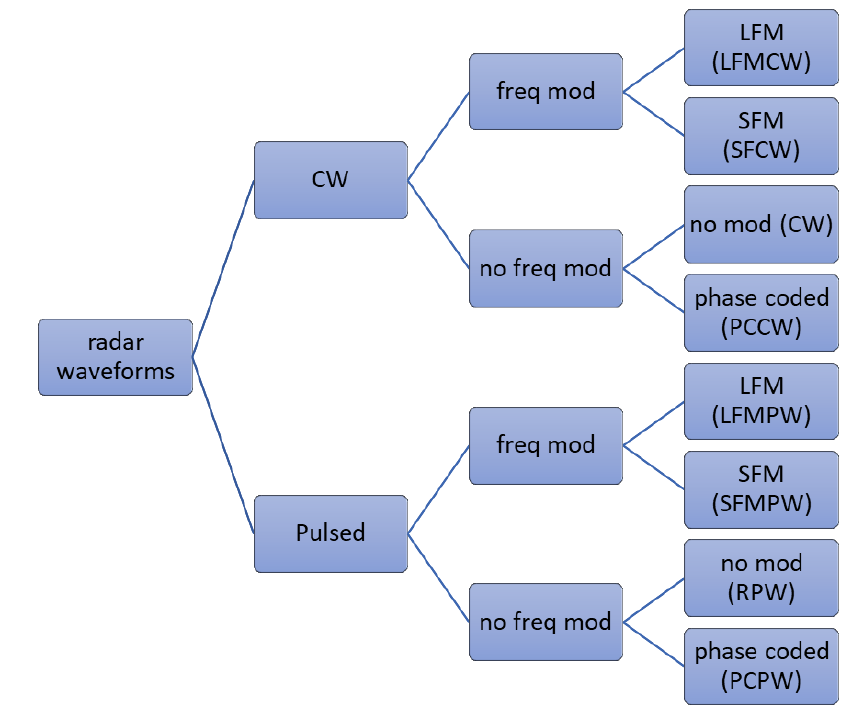
Figure 1. Considered type of